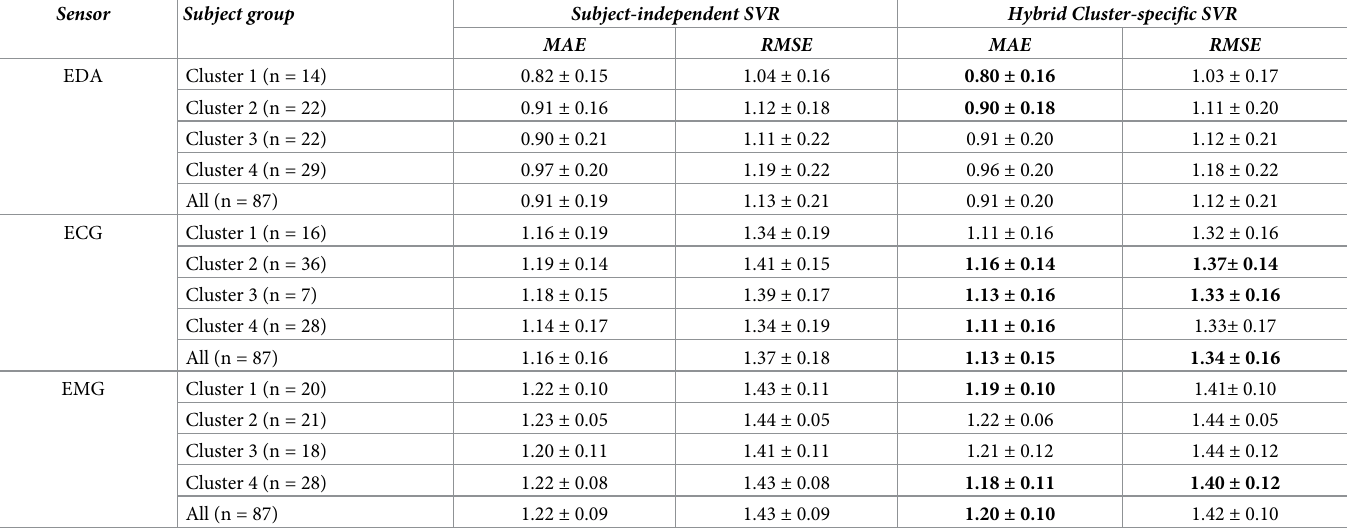
Table 8. Comparing hybrid clustering-based and generic pain estimation model